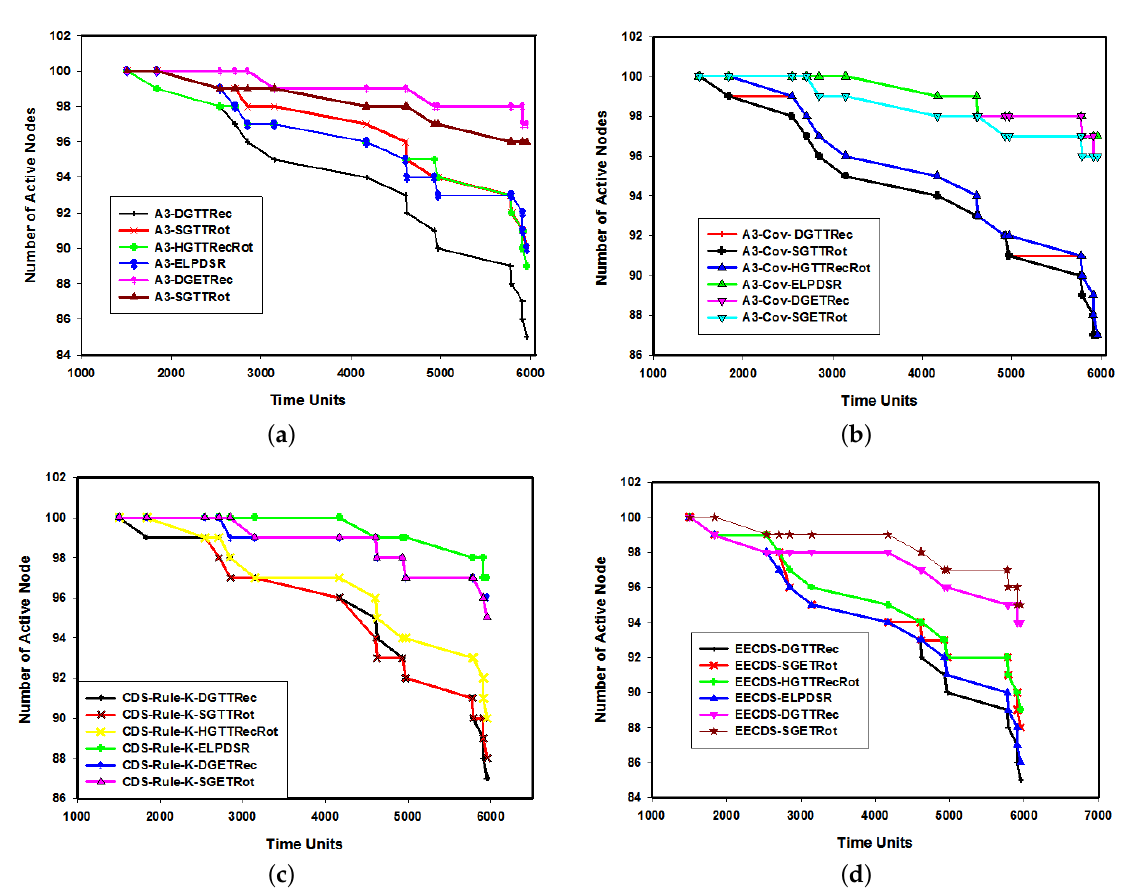
Figure 6. Topology maintenance for number of active nodes using ( a ) A3 construction protocol (A3), ( b ) A3 coverage (A3-Cov), ( c ) Connected Domain Set based on Rule K (CDS-Rule-K) and ( d ) Energy efficient connected domain set (EECDS)